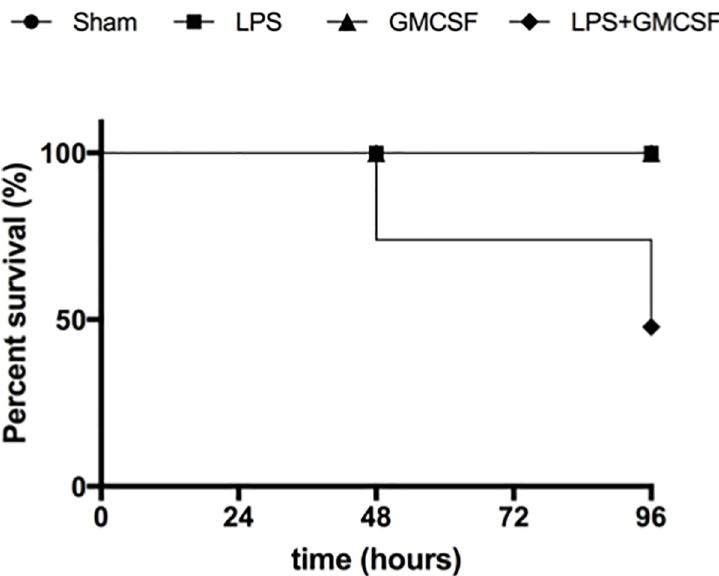
Fig 2. Mortality of the investigated animals. The Kaplan-Meier survival curve compares the mortality of the study groups (LPS+GM-CSF, n = 6; LPS, n, = 6; GM-CSF, n = 6; sham, n = 6). Sham, 96h after continuous saline infusion; GM-CSF, 96h after continuous saline infusion and daily granulocyte macrophage colony-stimulating factor (GM-CSF) injection; LPS, 96h after continuous lipopolysaccharide infusion; LPS+GM-CSF, 96h after continuous LPS infusion and daily GM-CSF